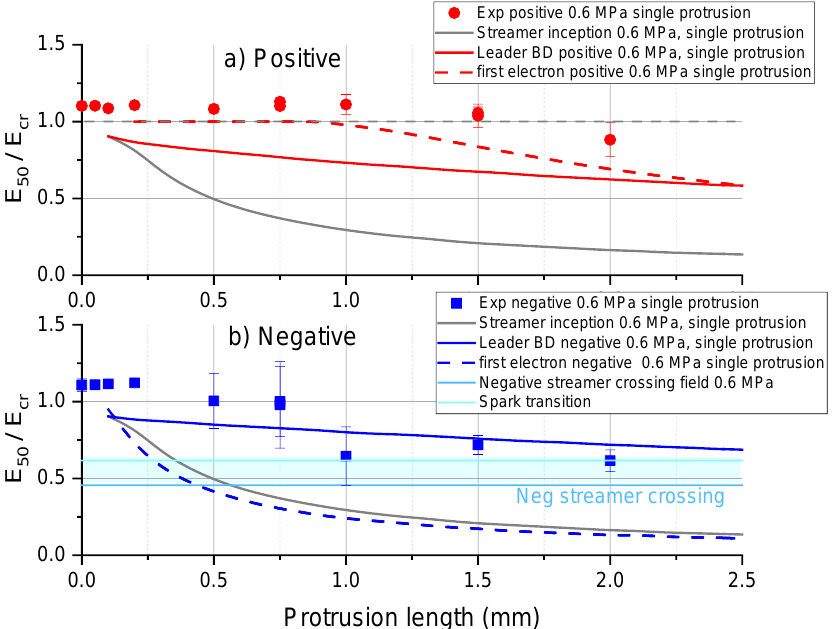
Figure 10. Normalized breakdown fields E 50 / E cr vs. protrusion length L for CO 2 and single protrusion at 0.6 MPa at ( a ) positive and ( b ) negative